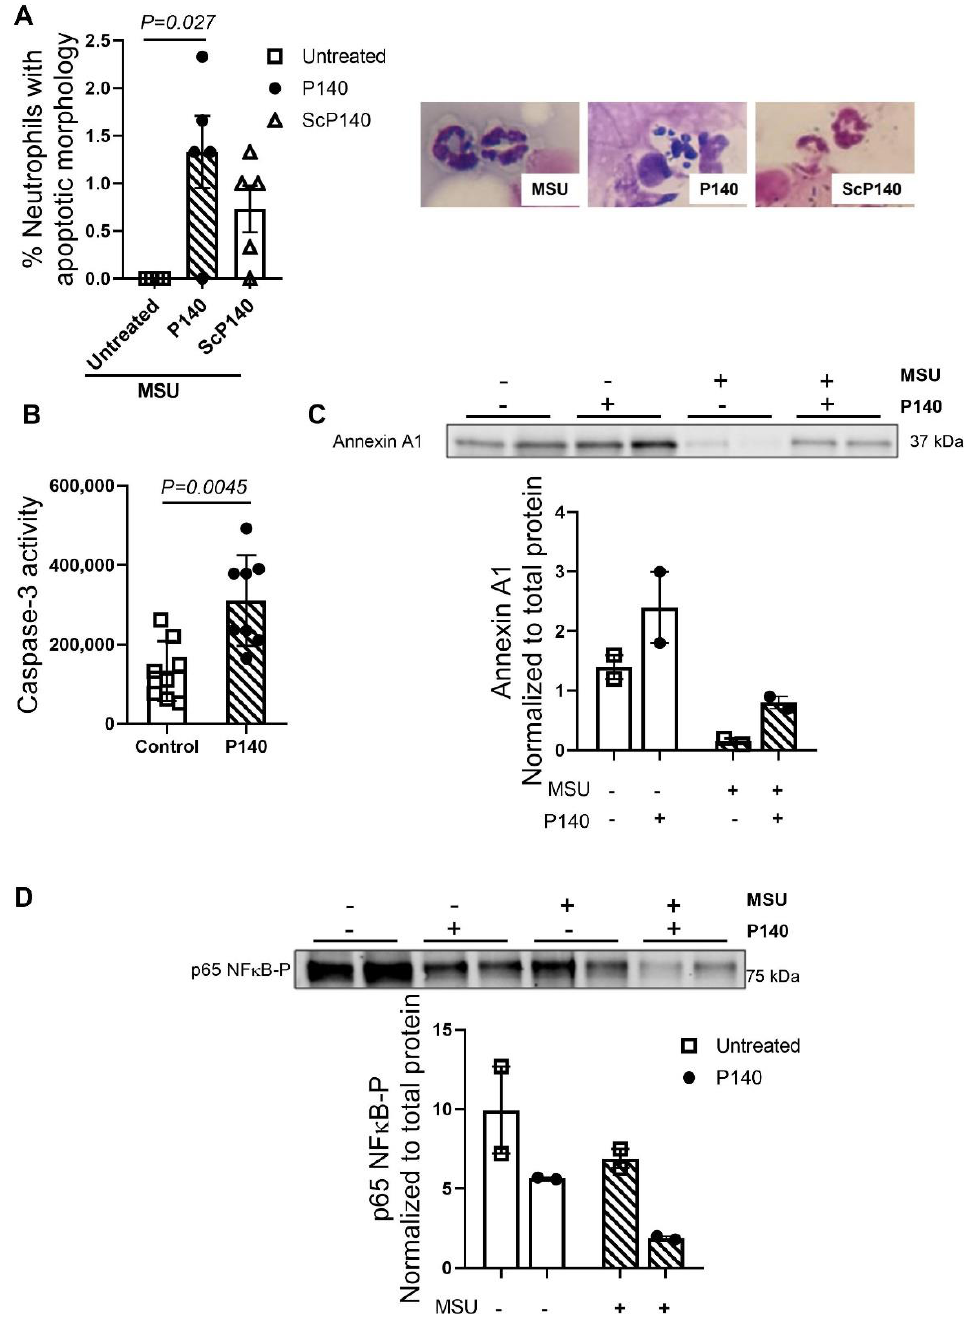
Figure 4. Effect of P140 peptide on the survival of neutrophils isolated from human peripheral blood. ( A ) In vivo percentage of neutrophils with apoptotic morphology measured in untreated, P140-, and ScP140-treated mice after gout induction. Pictures were representative of neutrophils collected from synovial fluid, stained, and count for distinctive apoptotic morphology. ( B ) Caspase-3 activity was measured in human neutrophils 4 h after P140 incubation. ( C ) Representative western blot images and protein quantification normalized to total protein for phosphorylated p65 NF κ B protein measured in neutrophils upon MSU stimulation and P140 treatment. ( D ) Representative western blot images and protein quantification normalized to total protein for annexin A1 in neutrophils upon MSU stimulation and P140 treatment. Data are mean ± SEM. p values were calculated using Mann–Whitney or Kruskal–Wallis tests following Dunn’s post hoc test.—means absence and + means presence.